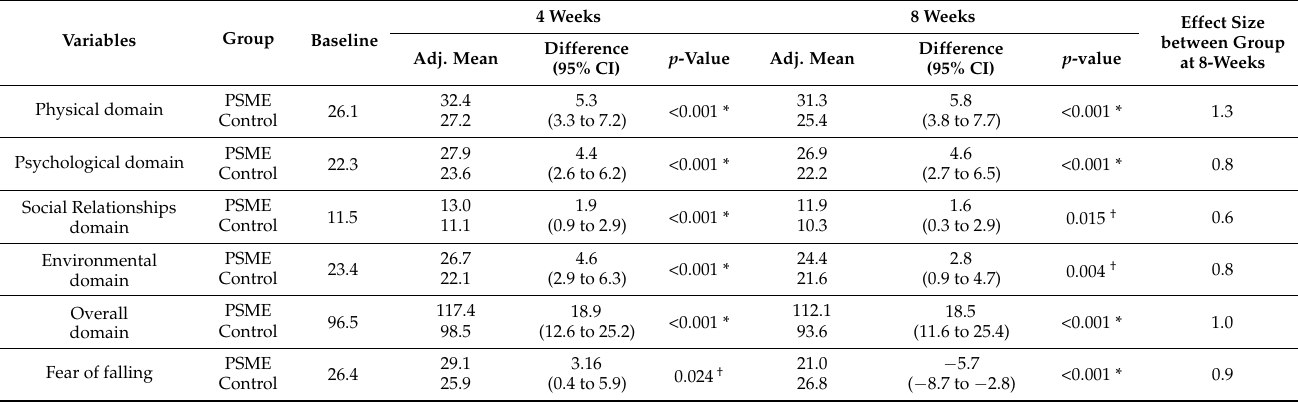
Table 6. Comparison of the adjusted mean and 95% CI difference of quality of life and fear of falling (ANCOVA) at each assessment session and effect size between the two